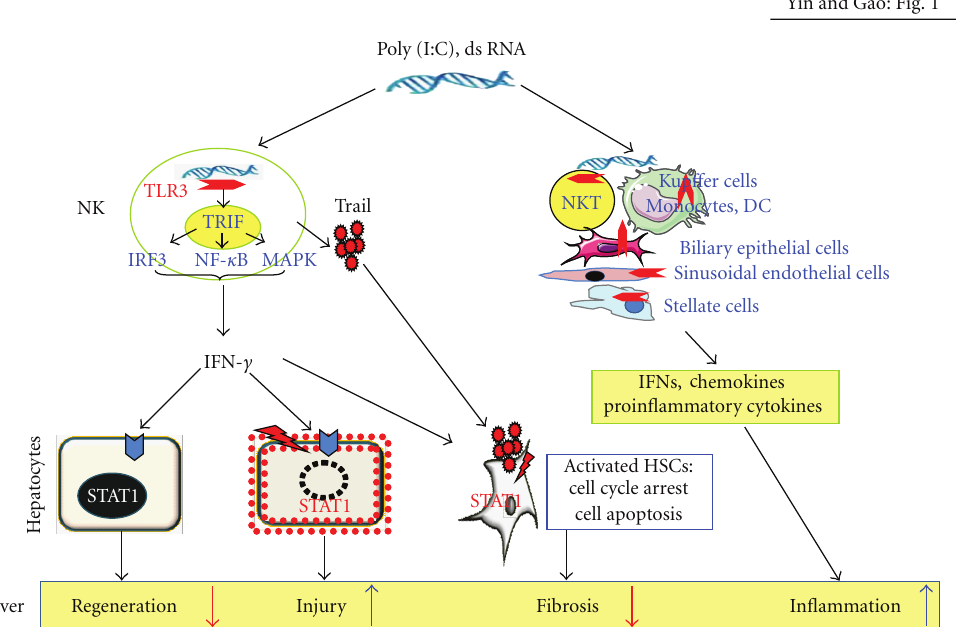
Figure 1: A model depicting the roles of TLR3 in liver injury, inflammation, regeneration, and fibrosis. Poly I:C or dsRNA binds TLR3 receptor in NK cells and stimulates NK cells to produce IFN- γ that induces hepatocyte cell cycle arrest and apoptosis via activation of STAT1. IFN- γ also induces stellate cell cycle arrest and apoptosis in an STAT1-depdent manner, resulting in inhibition of liver fibrosis. Poly I:C can also inhibit liver fibrosis via activation of NK cell killing of early activated stellate cells. In addition, poly I:C or dsRNA targets TLR3 in many other cell types, followed by production of IFNs, chemokines, and anti-inflammatory cytokines, resulting in liver